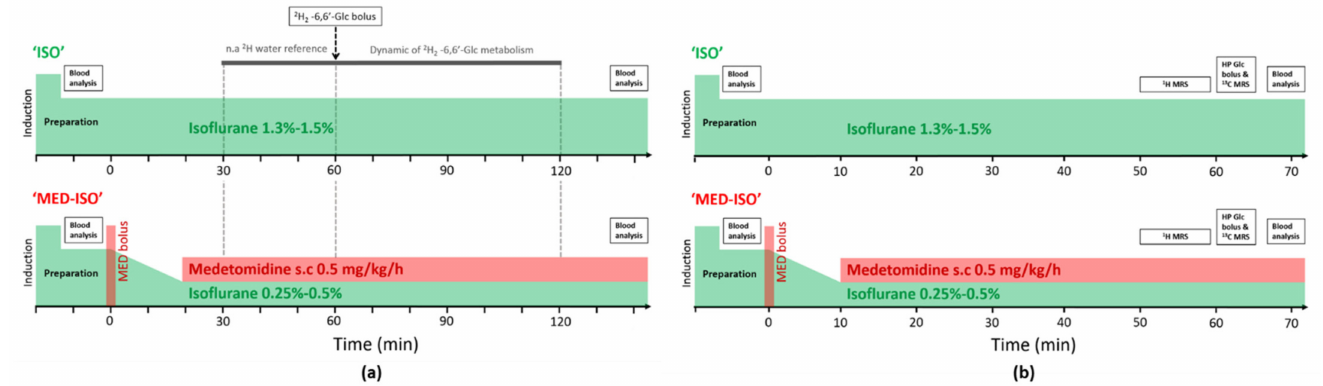
Figure 4. Outline of the experimental design and the anesthetic protocols for ( a ) the experiments using [6,6 (cid:48) - 2 H 2 ] Glc and ( b ) the experiments using HP [ 2 H 7 , U- 13 C 6 ]